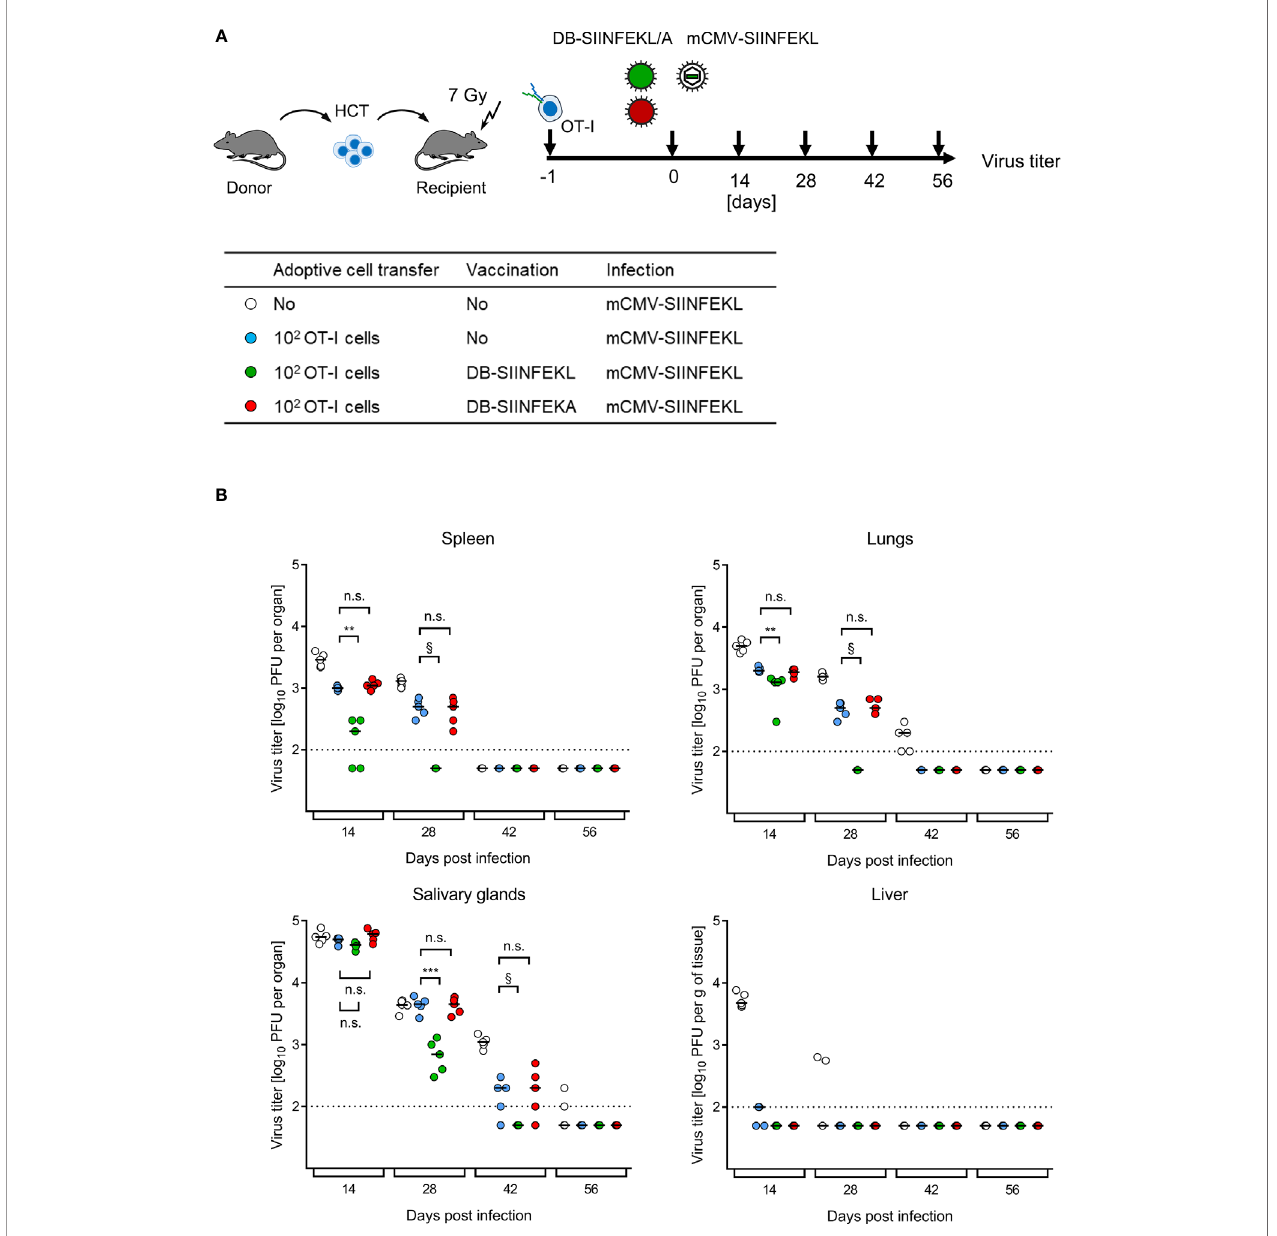
FIGURE 11 | Kinetics of epitope-speci fi c enhancement of protection by combining ACT with DB-based TherVac in HCT recipients. (A) Sketch of the protocol and table of experimental groups. Transiently immunocompromised C57BL/6 recipients of syngeneic HCT received ACT with 10 2 OT-I cells or were left with no ACT for control. On the following day, intraplantar TherVac with 20 m g of DB-SIINFEKL or control TherVac with 20 m g DB-SIINFEKA was combined with infection by 10 5 PFU of mCMV-SIINFEKL. Control of organ infection was assessed at the indicated times after infection. (B) Virus titers in organs indicated. Symbols, color-coded as de fi ned in (A, table), represent data from individually tested mice, with the median values marked. Signi fi cance levels (**) P < 0.01, (***) P < 0.001. (n.s.), not signi fi cant ( P > 0.05). §, de facto signi fi cant difference, although calculation of P values is pointless when all data of one group in the comparison are below the detection limit of the assay (dotted